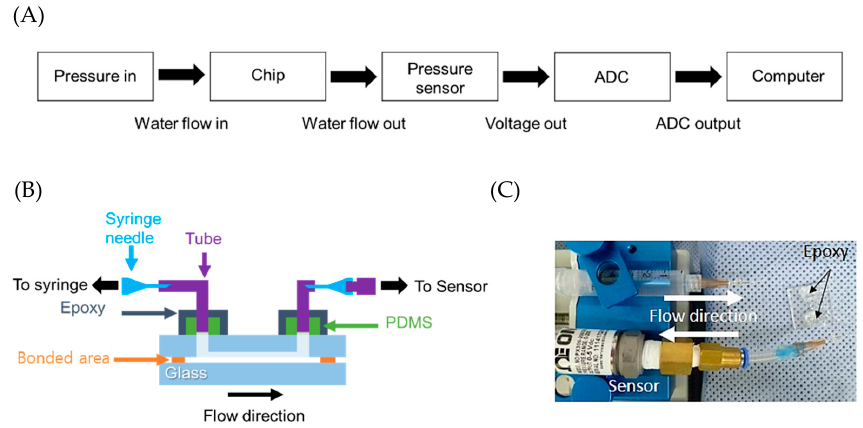
Figure 3. ( A ) Block diagram of the internal pressure measurement test procedure. ( B ) Configuration of interface between chip and peripheral devices and ( C ) the internal pressure measurement system. polydimethylsiloxane (PDMS) blocks were used as an interfacing material between tubing and the glass microfluidic device. Epoxy was applied around the PDMS block and tubing connection area. ADC—analogue to digital.